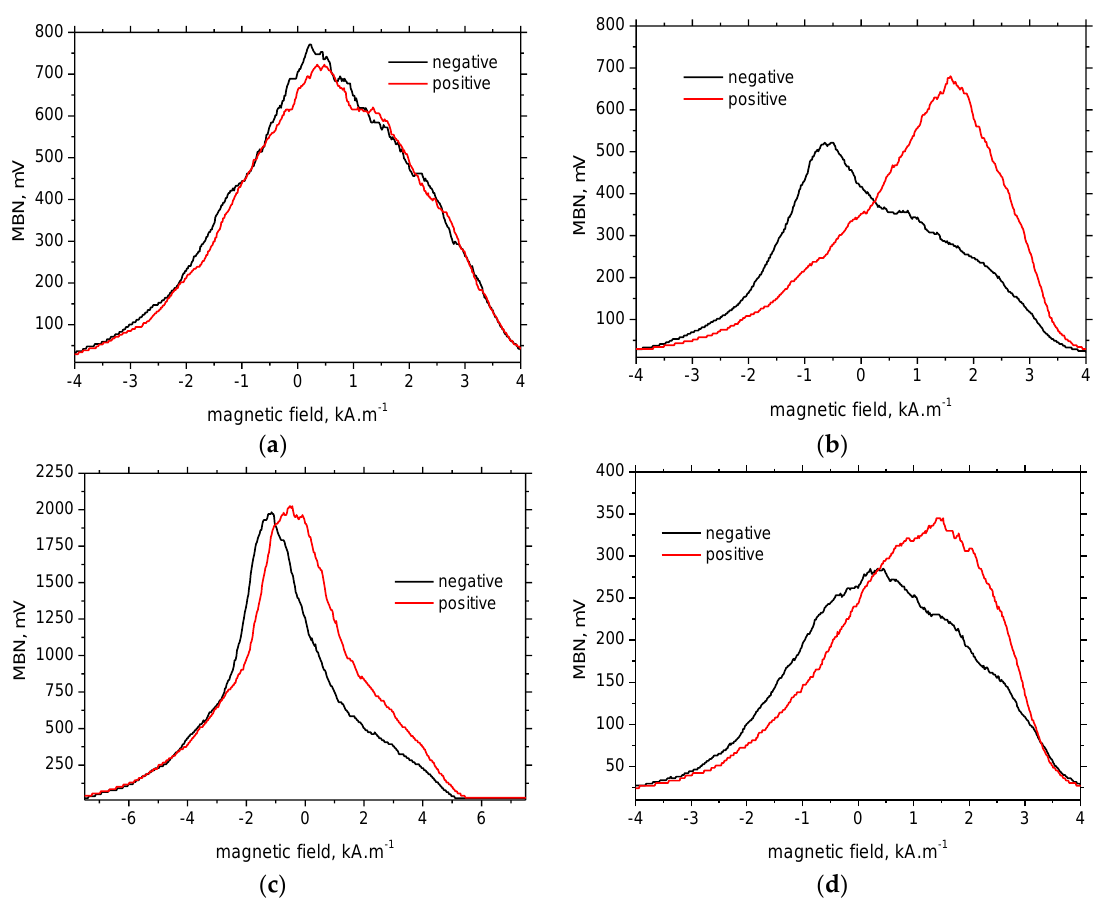
Figure 13. MBN envelopes in RD. ( a ) ε = 2.5%, 5V, ( b ) ε = 15%, 5V, ( c ) ε = 15%, 10V, ( d ) ε = 40%, 5V.